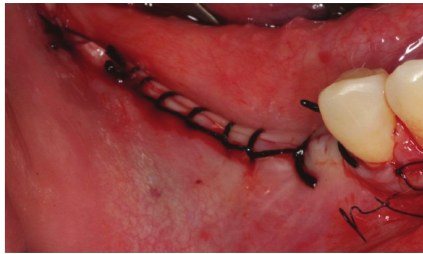
Figure 12: Osteotomy.